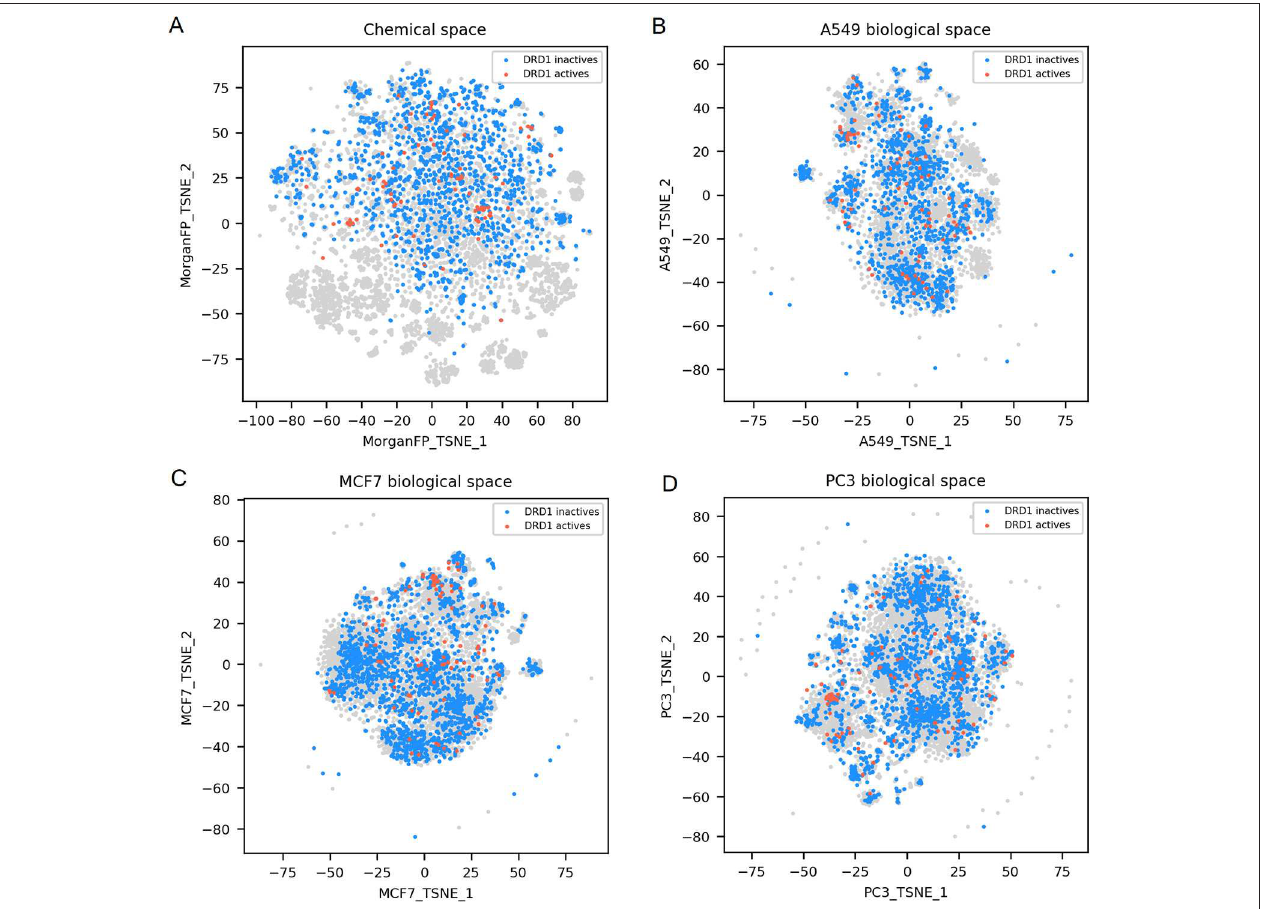
FIGURE 5 | DRD1 active and inactives compounds in the chemical space and the different biological spaces formed by GES produced in a single cell line. (A) Chemical space; (B) A549 biological space; (C) MCF7 biological space; (D) PC3 biological space. Points corresponding to DRD1 actives ( n inactives ( n 1843) are blue, gray points have no available label concerning DRD1 =